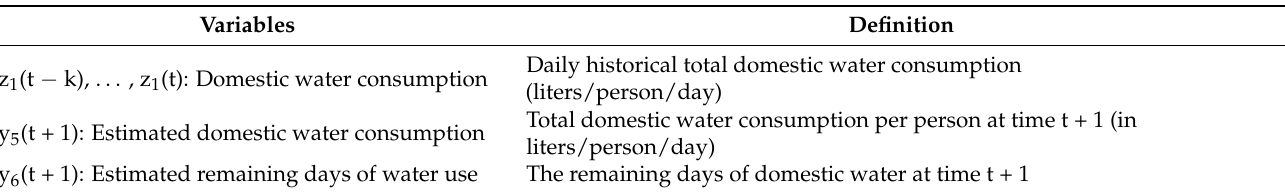
Table 2. Data description of domestic water